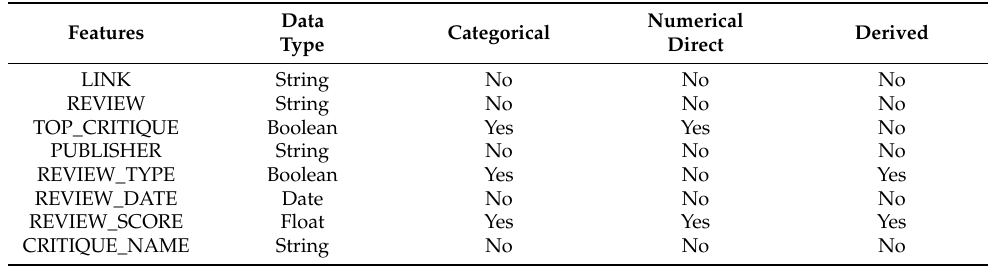
Table 3. Feature analysis of rotten tomatoes movie review (Data Source—Kaggle.com (accessed on 15 November